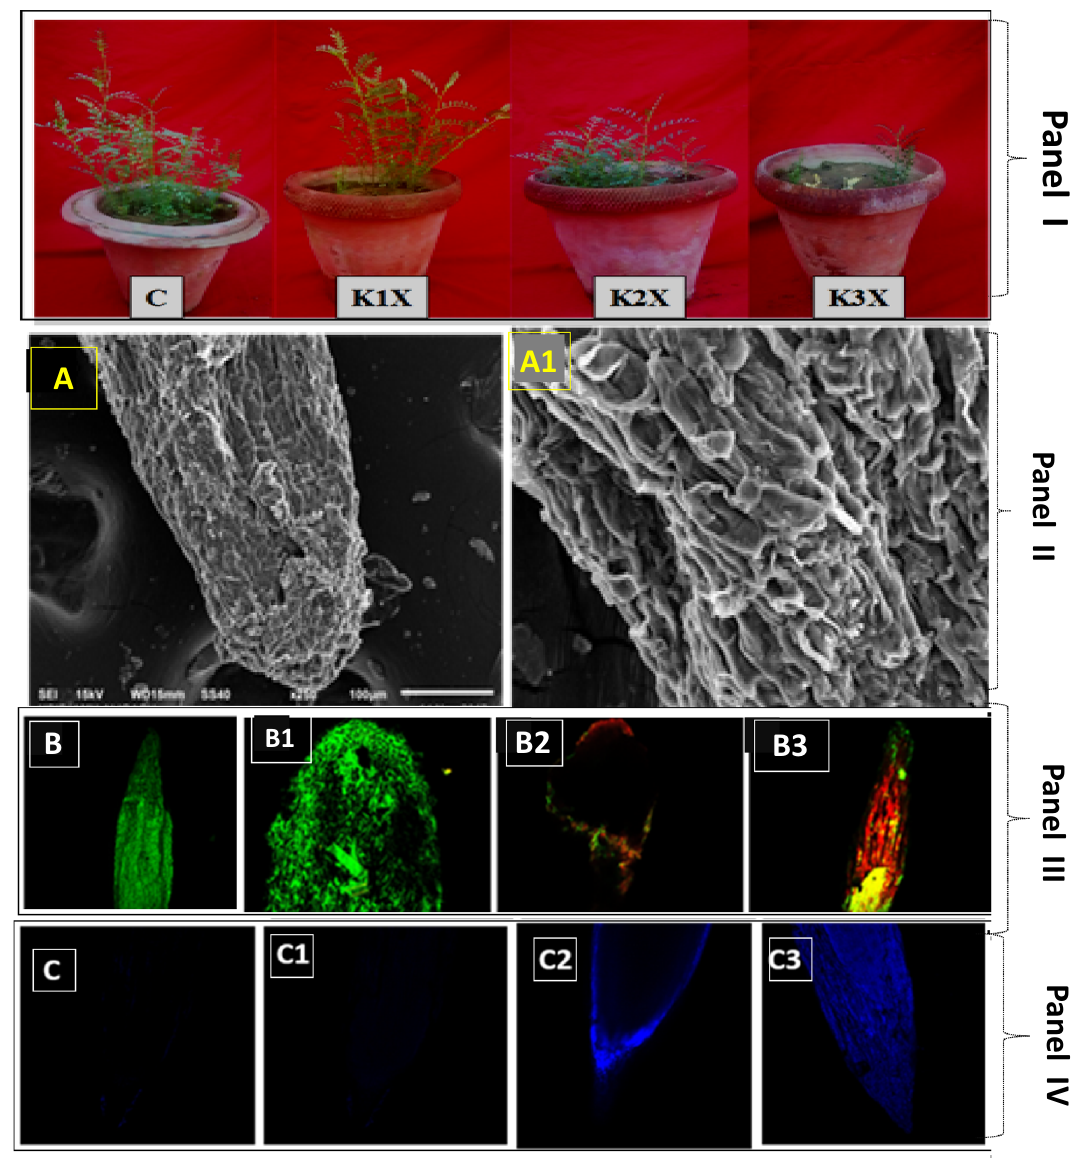
Figure 2. Effect of KITZ on C. arietinum plants grown with 96 (KITZ 1 ×), 192 (KITZ 2 ×) and 288 µg KITZ kg −1 (KITZ 3 ×) soil ( I ). Scanning electron microscopic (SEM) images of C. arietinum roots demonstrating distortion/damage induced by KITZ exposure: ( A ) represents the root tip and root surface of untreated/control. Whereas, ( A1 ) represent the distorted/ruptured root tips and root tip surfaces treated with KITZ ( II ). The Z-stack images of PI/AO stained C. arietinum roots using CLSM. Images reveal an increase in red/orange fluorescence as concentrations of KITZ increase. Untreated control root showing no red color ( B ), while roots treated with various doses of KITZ ( B1–B3 ) ( III ). The Z-stack image of chickpea using CLSM representing the cytotoxicity (Evans blue dye exclusion) assay in root tissues induced by fungicide. Figures show uptake of Evans blue dye by root cells; untreated control root showing no blue color ( C ), while ( C1 – C3 ) represents the roots treated with various doses of KITZ ( IV